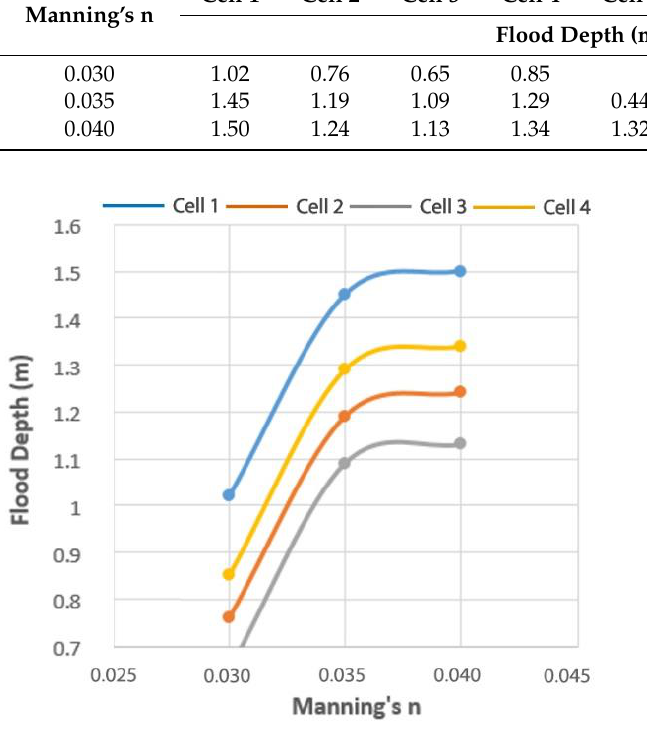
Figure 8. Change in the maximum flood depth (Cells 1–4) value for different Manning’s n in sub-reach K6.